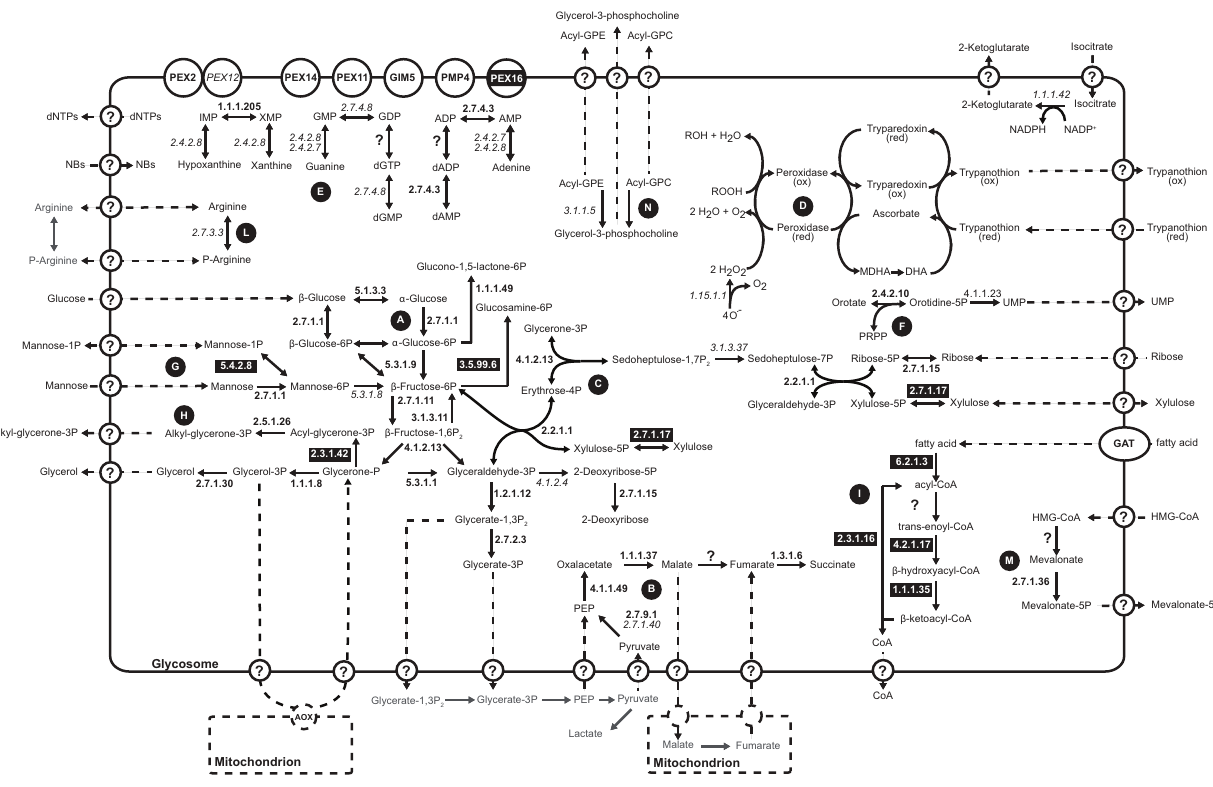
Figure 2. Putative glycosomal pathway scheme. The scheme summarizes metabolic pathways identified so far in the glycosomes of Leishmania and T. brucei . EC numbers of enzymes identified only in the Leishmania glycosome are indicated in black boxes with white text, those identified only in T. brucei are indicated in italics, and those found in the glycosome of both species are indicated in bold. Predicted transport processes across the glycosomal membrane are indicated by the circled question marks and dashed arrows. Letters in black circles indicate the different metabolic pathways as follows: A: glycolysis; B: succinic fermentation; C: pentose phosphate pathway; D: superoxide and trypanothione metabolism; E: purine salvage; F: pyrimidine metabolism; G: mannose metabolism; H: glycerolipid biosynthesis; I: b -oxidation of fatty acids; L: phosphoarginine metabolism; M: mevalonate pathway; N: phospholipid degradation. Abbreviations used are: Acyl-GPC, 1-acyl-glycero-phosphocholine; Acyl-GPE, 1-acyl- glycero-phosphoethanolamine; AOX, alternative oxidase; DHA, dehydroascorbate; MDHA, monodehydroxyascorbate; NB, nucleobases; PRPP, 5-phosphoribosyl